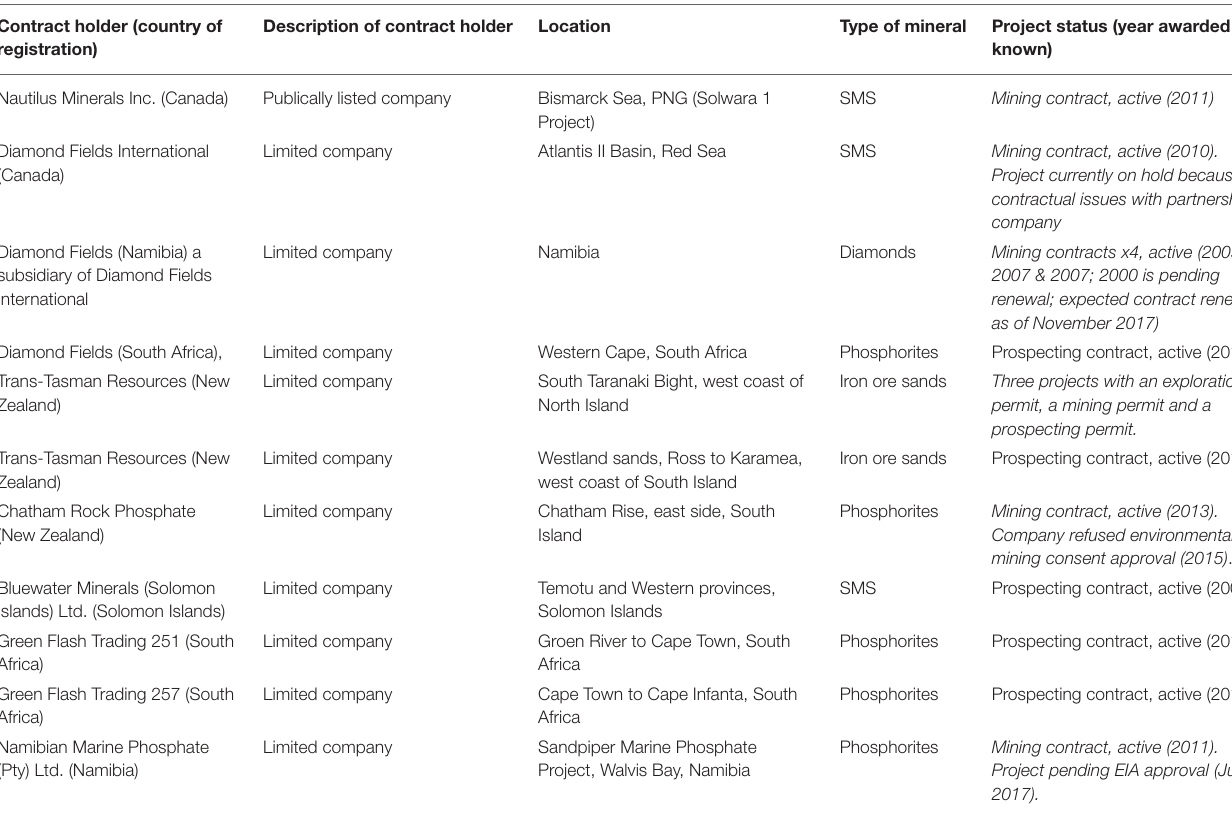
TABLE 3 | A summary of some seabed mining operations on continental